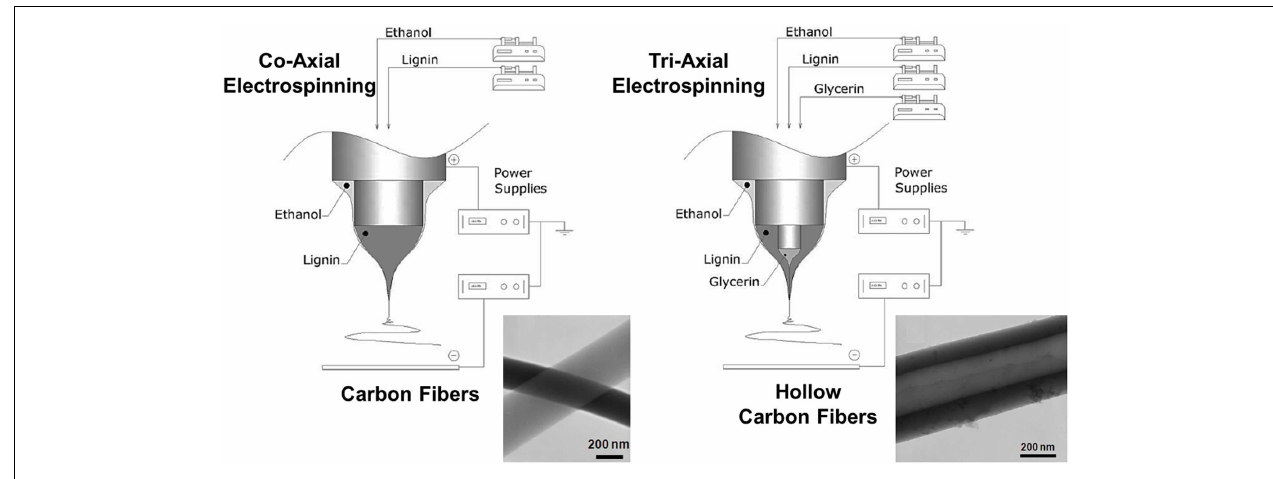
FIGURE 5 | General set-up used in co-axial and tri-axial electrospinning to produce lignin-based CFs and hollow CFs, respectively, adapted from Ruiz-Rosas et al.